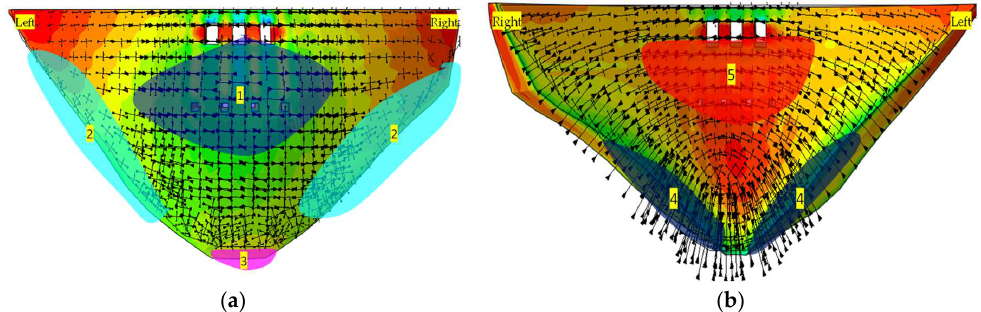
Figure 14. Five stress zones of high arch dam. ( a ) Upstream surface; ( b ) Downstream surface. Note: The number 1-5 represents compression zone of upstream surface, tensile and compressive zone of upstream arch abutment, tensile stress zone of upstream dam heel, compression stress zone of downstream arch abutment, and tensile stress zone of downstream surface, respectively.